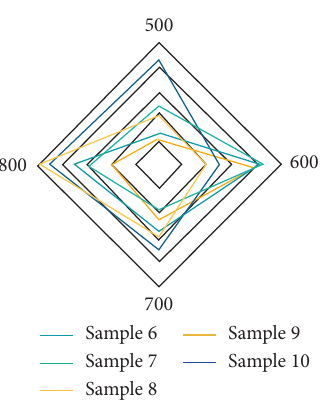
Figure 4: Laser fluorescence of samples